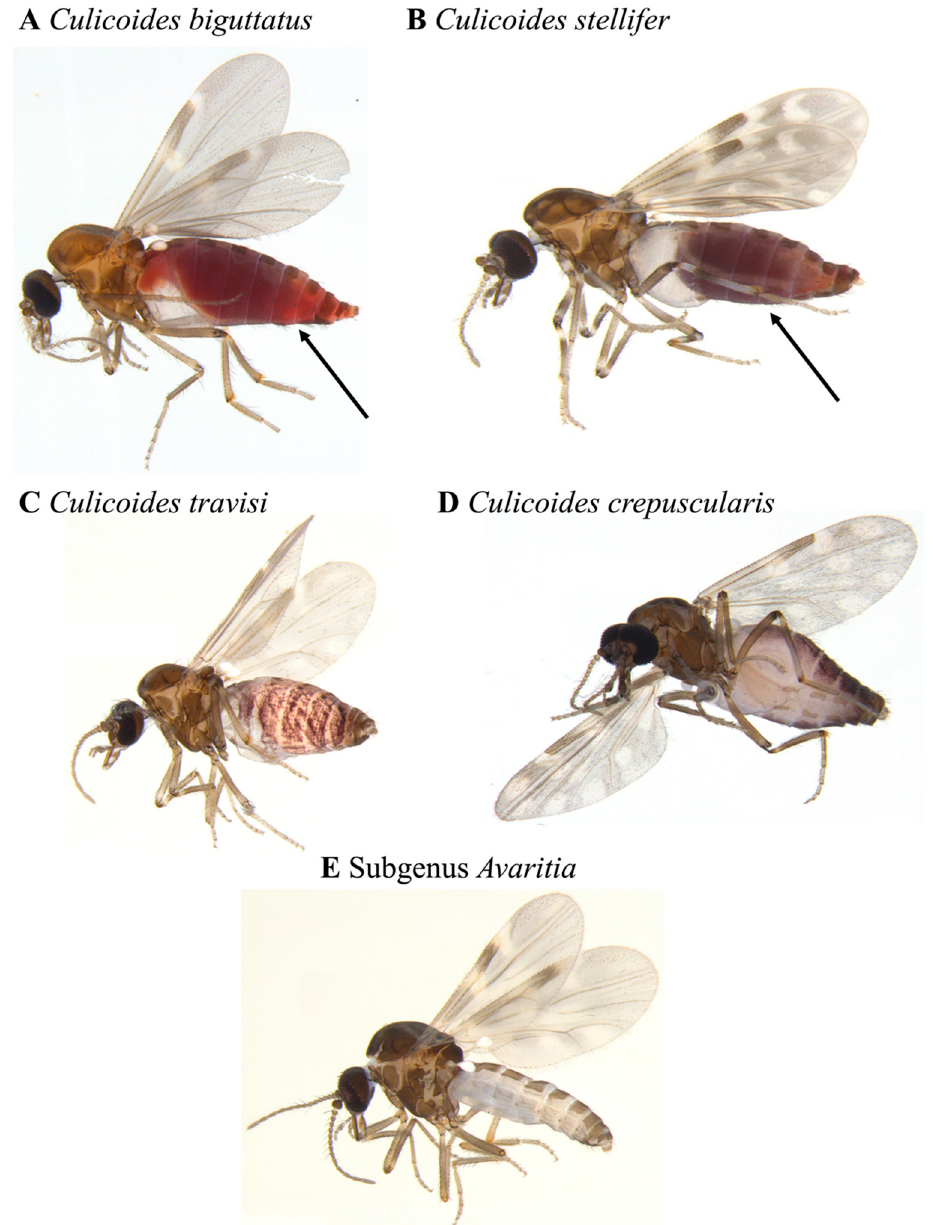
Figure 3. Representative images of Culicoides specimens, morphologically identified from the Dairy Barn trap, showing a left lateral orientation. Arrows indicate abdomens containing a blood meal. Specimens ( A – E ) are females.